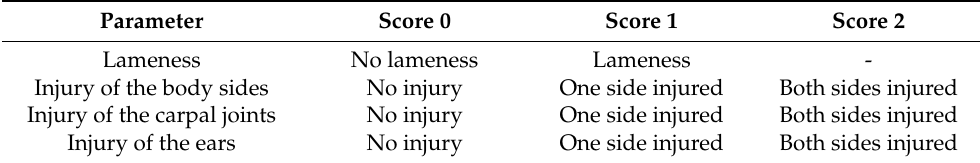
Table 2. Scoring scheme of the general health condition (modified after [43]).